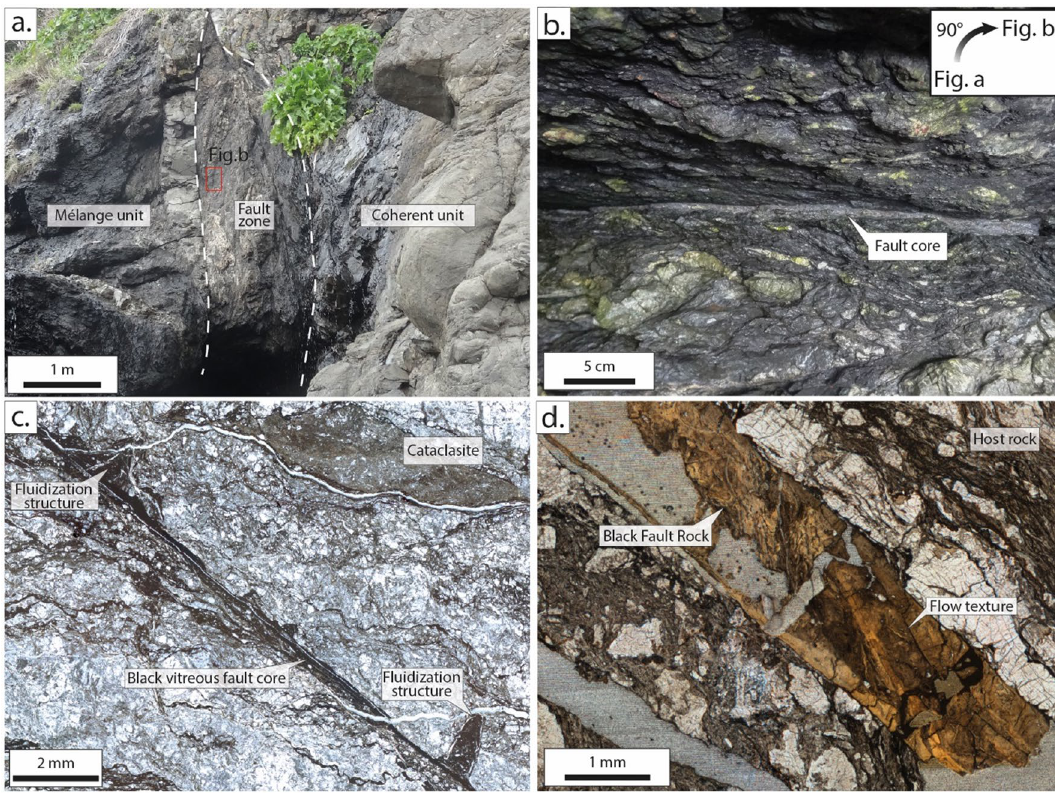
Figure 1. Structures and micro- to nano-structures of the Black Fault Rocks observed in fossil accretionary complexes. ( a ) Meter-thick fault zone between the Mugi mélange unit and a coherent unit in the Shimanto Belt ( b ) Close-up view of the fault zone with the fault core ( c ) Fluidization structures (embayment and injection vein) and Black Fault core in the Okitsu Black Fault Rock ( d ) Flow textures inside the Nobeoka Black Fault Rock Locations: ( a , b ) Mugi mélange ( c ) Okitsu mélange ( d ) Nobeoka Tectonic Line